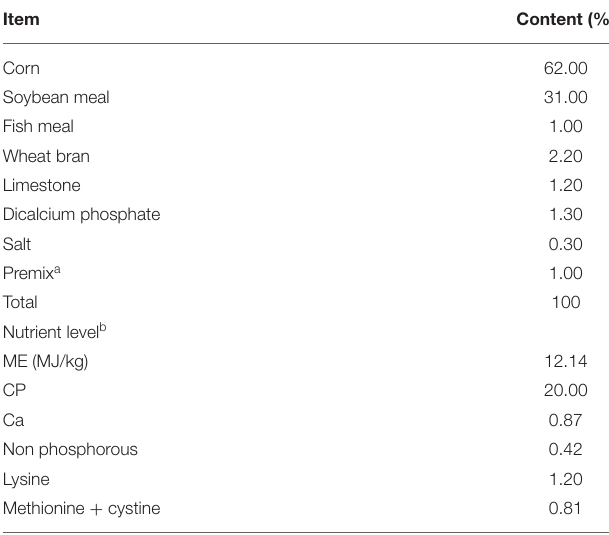
TABLE 1 | Composition and nutrient levels of basal diets (air-dry basis,